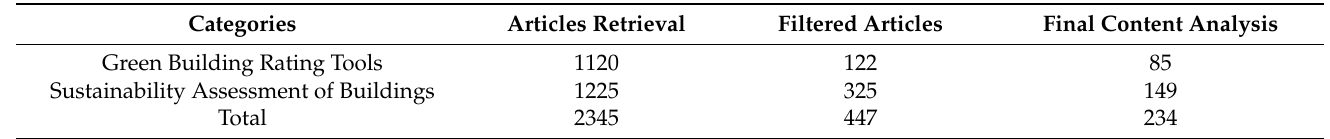
Table 1. Articles retrieved and shortlisted for final content